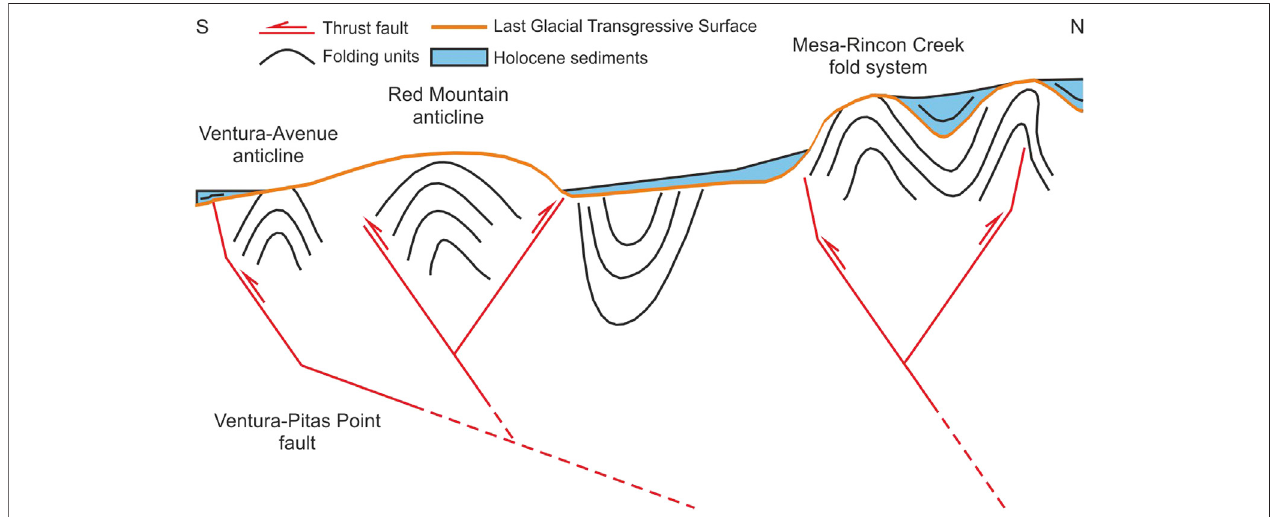
FIGURE 14 | Conceptual schematic cross-section showing the possible relationship between the deformation of the Last Glacial Transgressive Surface and deeper blind thrust faults in an area between Carpinteria and Santa Barbara and perpendicular to the shoreline. There are no vertical and horizontal scales.